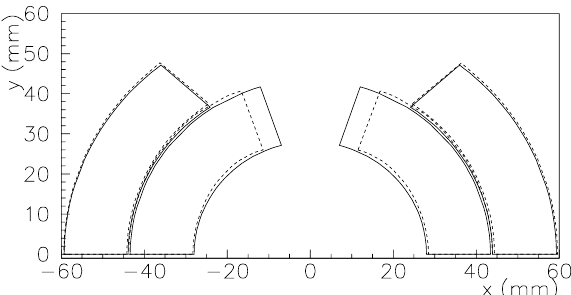
FIG. 5. Nominal coil geometry (solid line) and deformed ge- ometry (dashed line) induced by a 0.1 mm thicker shim in the inner coil. Deformations are magnified by a factor of